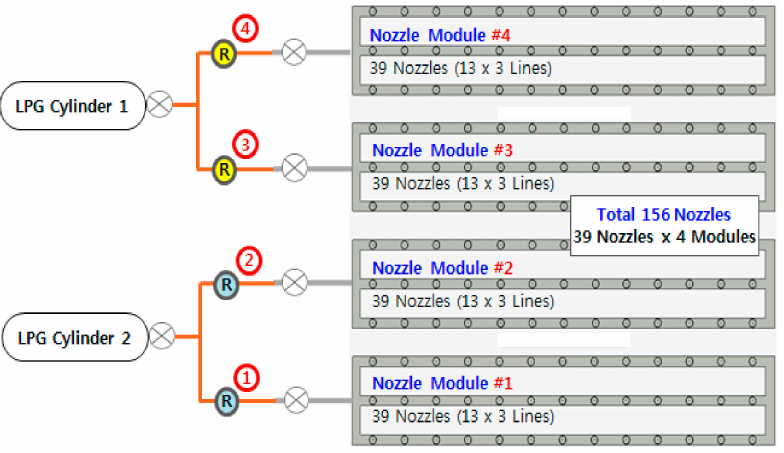
Figure 2. Schematic diagram of modulated burner installation with LPG supply system; ® means